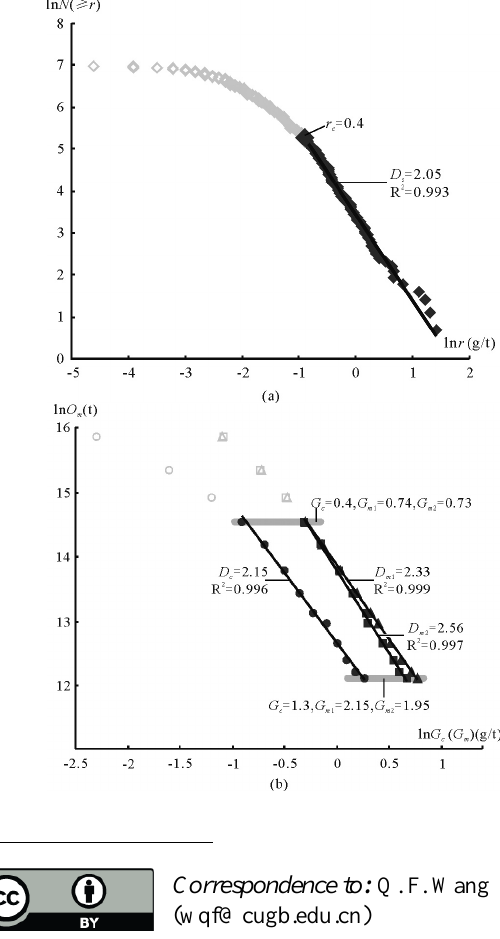
Fig. 7. Fractal model of the gold concentrations in the core samples collected from the 10 selected drill holes, and the tonnage-cutoff and tonnage-grade curves for the selected exploration area in the Reshuitang deposit. (a) Fractal model of the gold concentrations in the core samples; (b) the ln–ln plots of tonnage vs. cutoff and those of tonnage vs. average grade, approving both tonnage-cutoff model and tonnage-grade model display the fractal relationship with the similar fractal dimensions in this case study. G m1 is obtained by a thickness weighted average gold concentrations of all the samples analyzed in the selected drill holes. G m2 is the average grade de- rived from GBM. The circles, triangles and rectangles represent the plots of O( ≥ G c ) vs. G c , O( ≥ G c ) vs. G m1 , and O( ≥ G c ) vs. G m2 , respectively; and the black and solid symbols are the plots contained in the fitting, and the grey and hollow plots are not involved in the